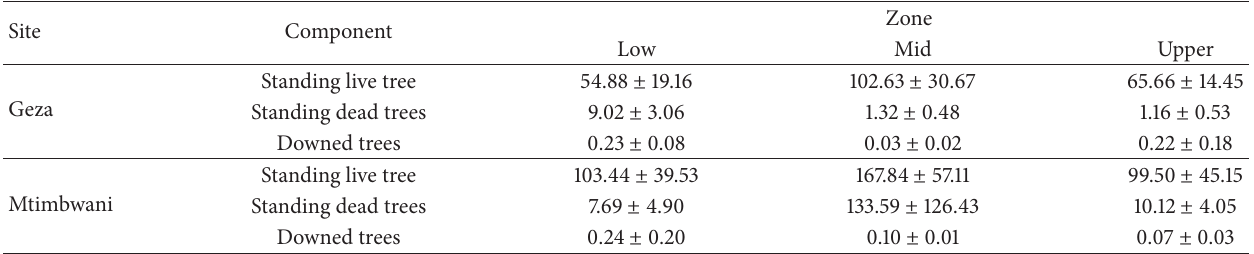
Table 2: Mean AGC density (Mg C ha −1 ) for standing live, dead and downed trees (mean ±